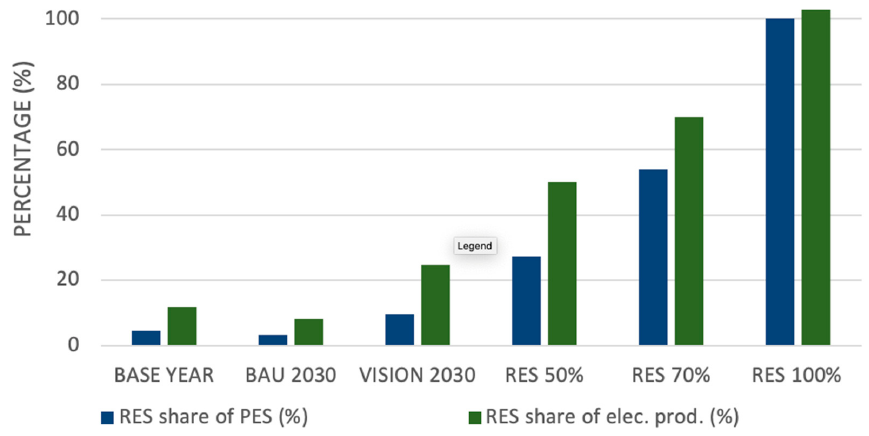
Figure 9. Renewable energy penetration rate (%) of primary energy supply in electricity production (PES) and share of electricity production 2019 and for the five scenarios by